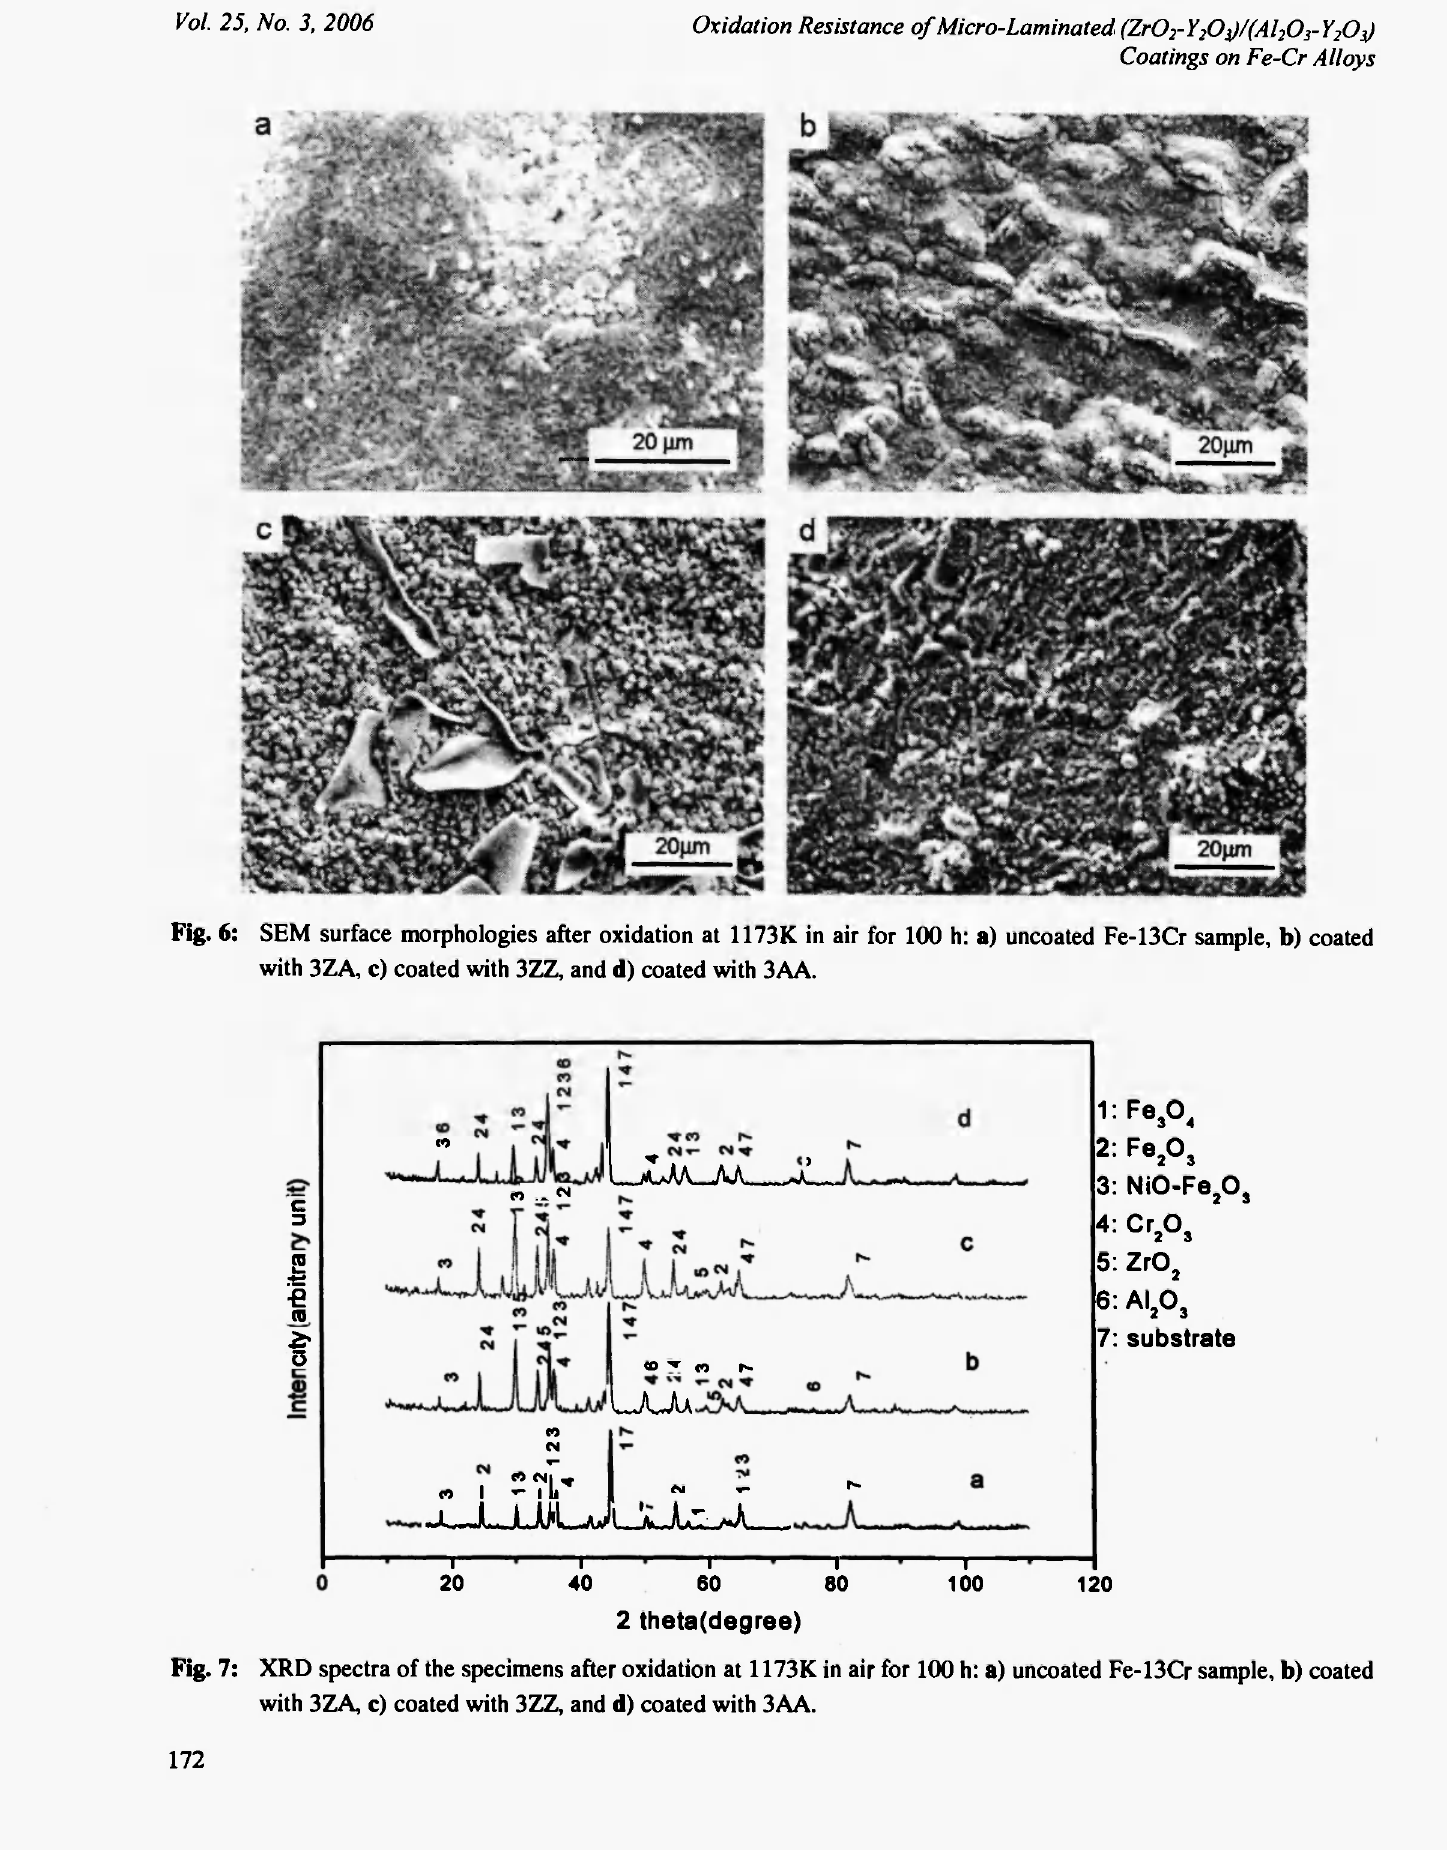
Fig. 7: XRD spectra of the specimens after oxidation at 1173K in air for 100 h: a) uncoated Fe-13Cr sample, b) coated with 3ZA, c) coated with 3ZZ, and d) coated with